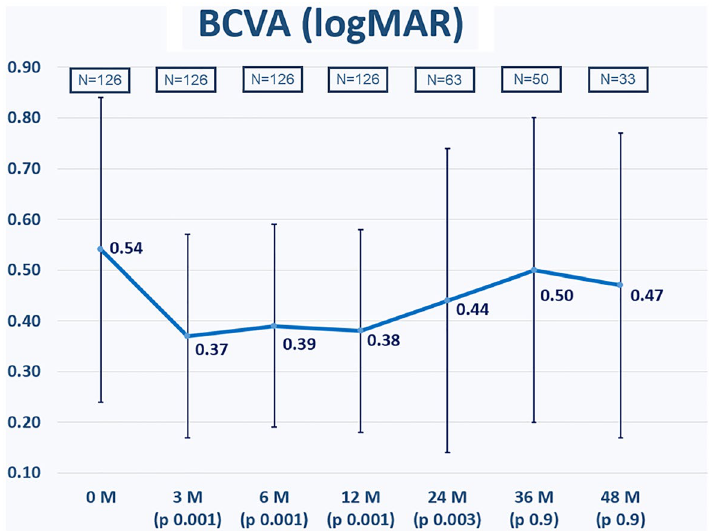
Figure 3. The change in best-corrected visual acuity (BCVA, logMAR) during the study observation period. p values refer to statistical differences between each time points and baseline: BCVA improved significantly at 6 months (p = 0.001), 1 year (p = 0.001), and 2 years (p = 0.003) but not significantly after 3 years (p = 0.9) and 4 years (p = 0.9) after the first intravitreal injection.